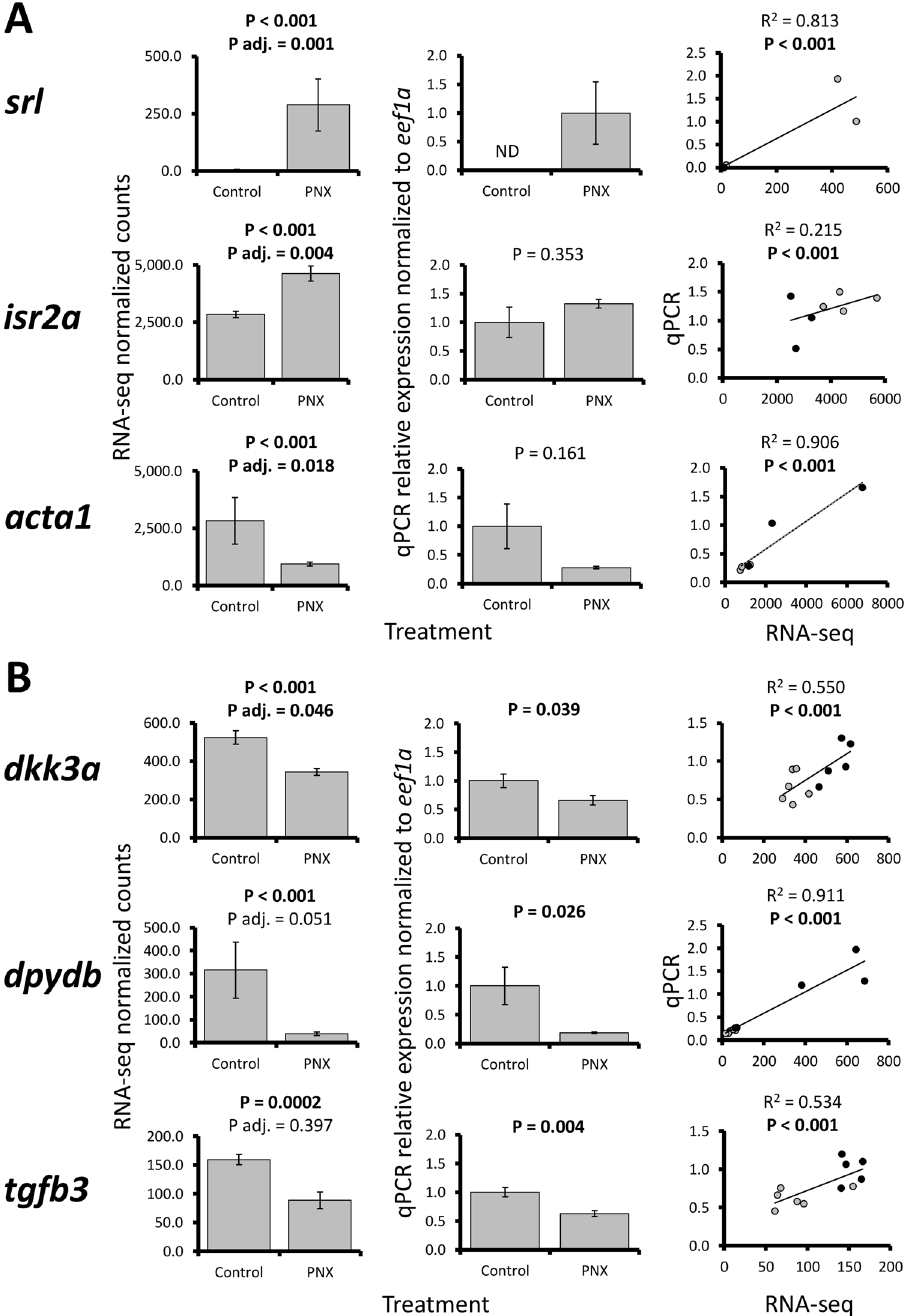
Figure 2. RNA-seq normalized count data (first column), relative mRNA expression in qPCR normalized to eef1a (second column), and linear regression analyses (third column) of selected ovary [( A ) srl , isr2a , and acta1 ] and hypothalamus genes [( B ) dkk3a , dpydb , and tgfb3 ]. Each bar represents the mean ± standard error and significance was assessed at P < 0.05. P adjusted (adj.) refers to the multiple test correction in RNA-seq differential expression analyses (false discovery rate < 0.05). For regression analyses, black and gray circles refer to control and PNX-14 treated samples,